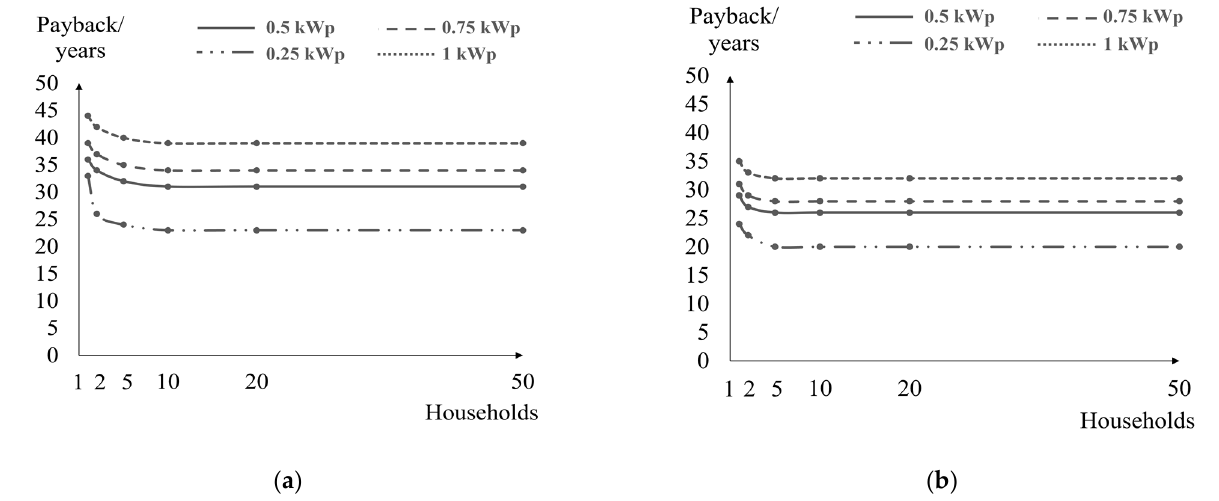
Figure 10. ( a ) Average payback in different combinations with different PV systems considering an electricity price growth of 2%; ( b ) average payback in different combinations with different PV systems considering an electricity price growth of 3%.